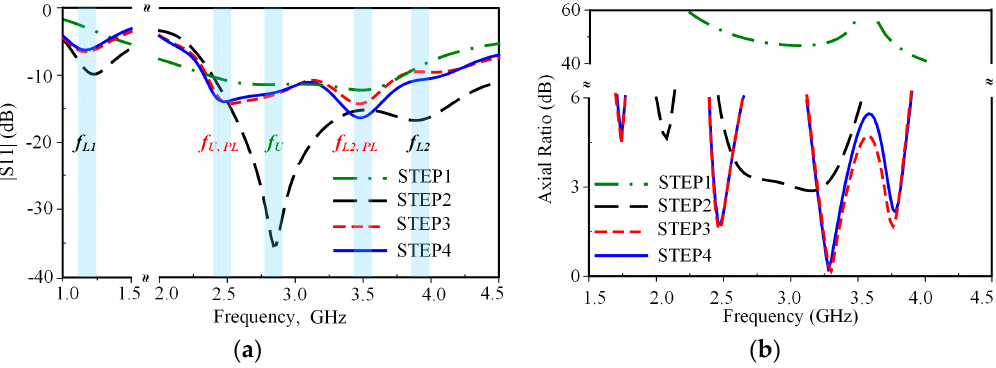
Figure 4. Improvement of antenna characteristics for four design steps: ( a ) S11; ( b ) axial ratio.